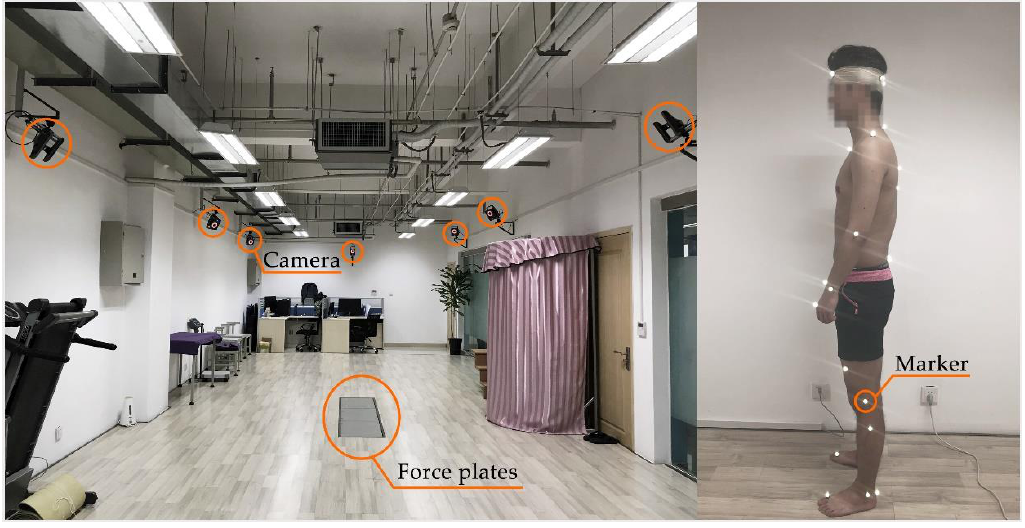
Figure 1. The experimental scene.